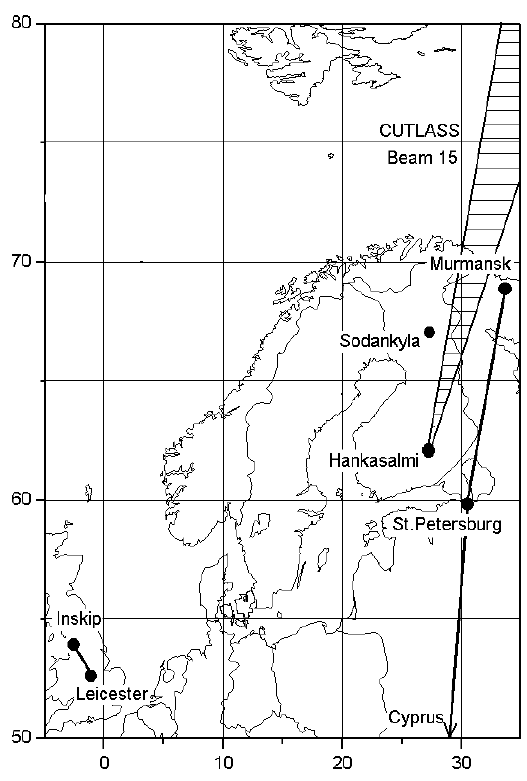
Fig. 1. Map showing the locations and paths of the various HF instrumentation employed in these experiments. The GPS measure- ments fall in the range between latitudes of 40 ◦ and 70 ◦ N and lon- gitudes of 10 ◦ W and 40 ◦